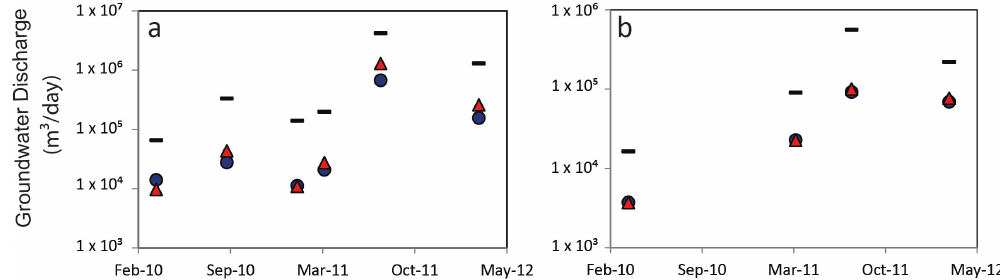
Fig. 11. Temporal variations in river discharge (black lines) and groundwater discharge to the Tambo River (a) and Nicholson River (b) given by 222 Rn mass balance using O’Connor and Dobbins (1958) (blue circles) and Negulescu and Rojanski (1969) (red triangles) models of gas transfer.